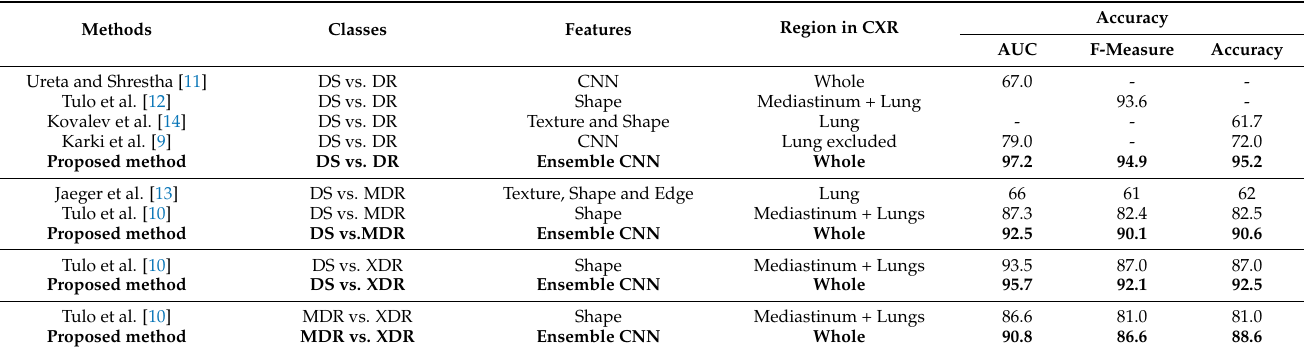
Table 3. The accuracy of the proposed methods with the existing heuristics to classify DS-TB, DR-TB, MDR-TB, and